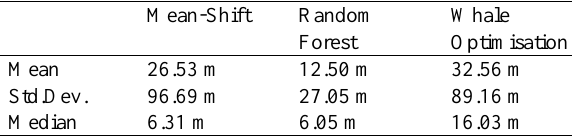
Table 6. Quality assessment statistics of the shorelines derived from fuzzy clustering with use of estimated